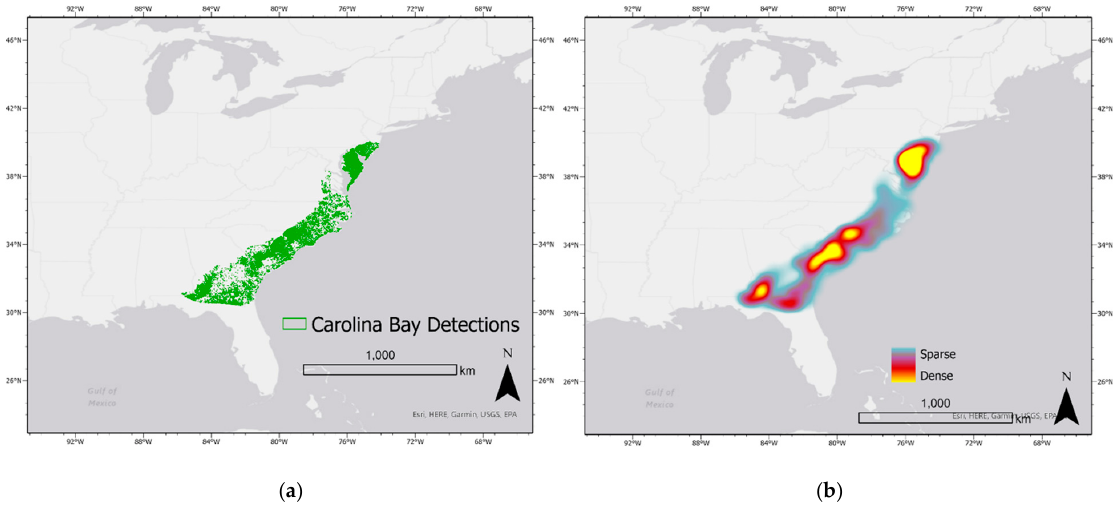
Figure 12. ( a ) Carolina Bay detections across the ACP. ( b ) Heat map of Carolina Bay detections showing higher vs lower density areas.